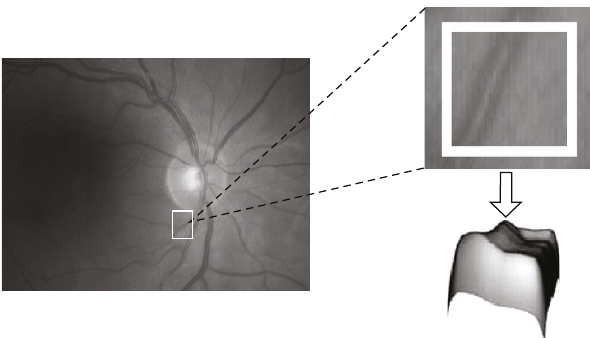
Figure 1: Representation of a region in the image as a landscape. Left side shows the retinal image with the region of interest marked with a white rectangle. In the right side, the zoomed image over the region of interest and the same region represented as a landscape, showing the creaseness